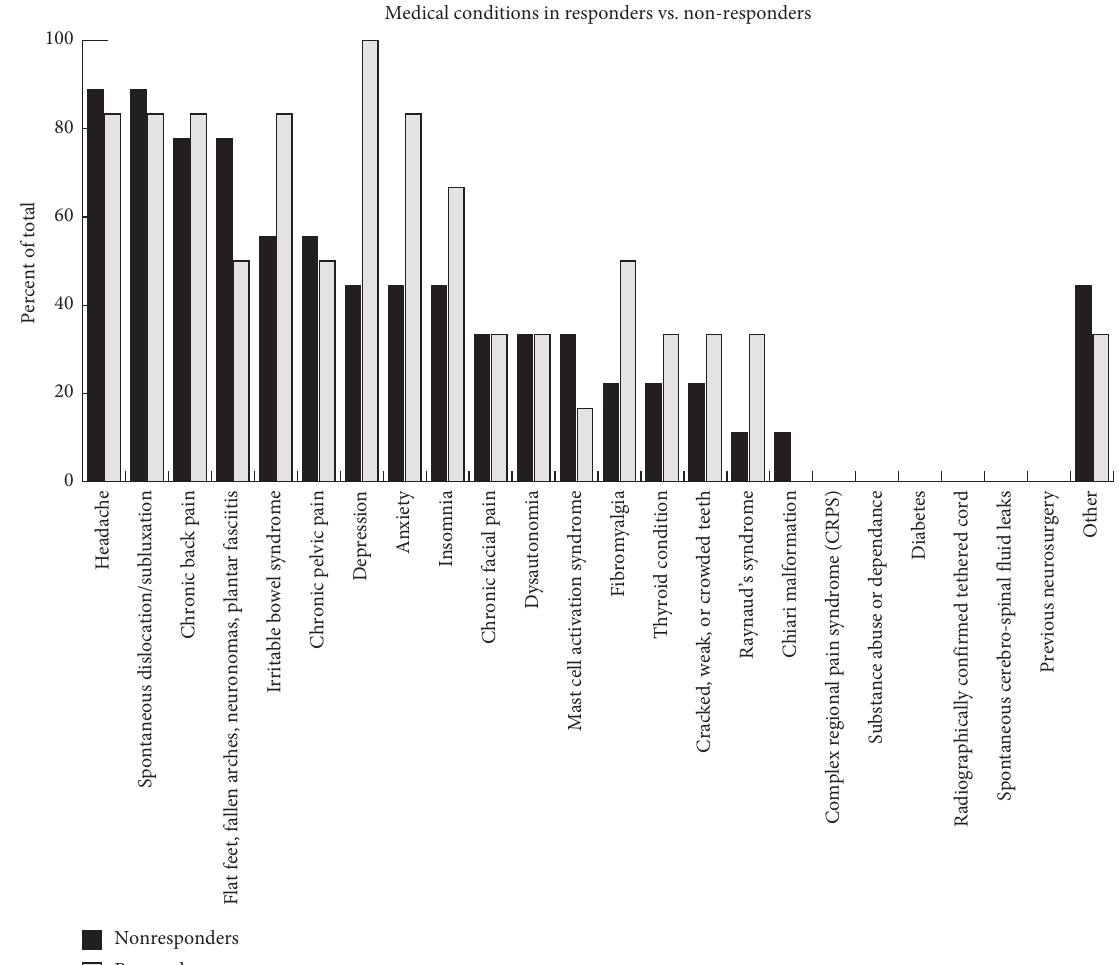
Figure 4: Histogram depicting the percent of total responders or nonresponders that reported having each medical condition. Nonre- sponders are represented in black bars, and responders are in grey. The y -axis represents the number of participants with each condition as a percentage of total participants. Bolded conditions represent those we considered different between responders and